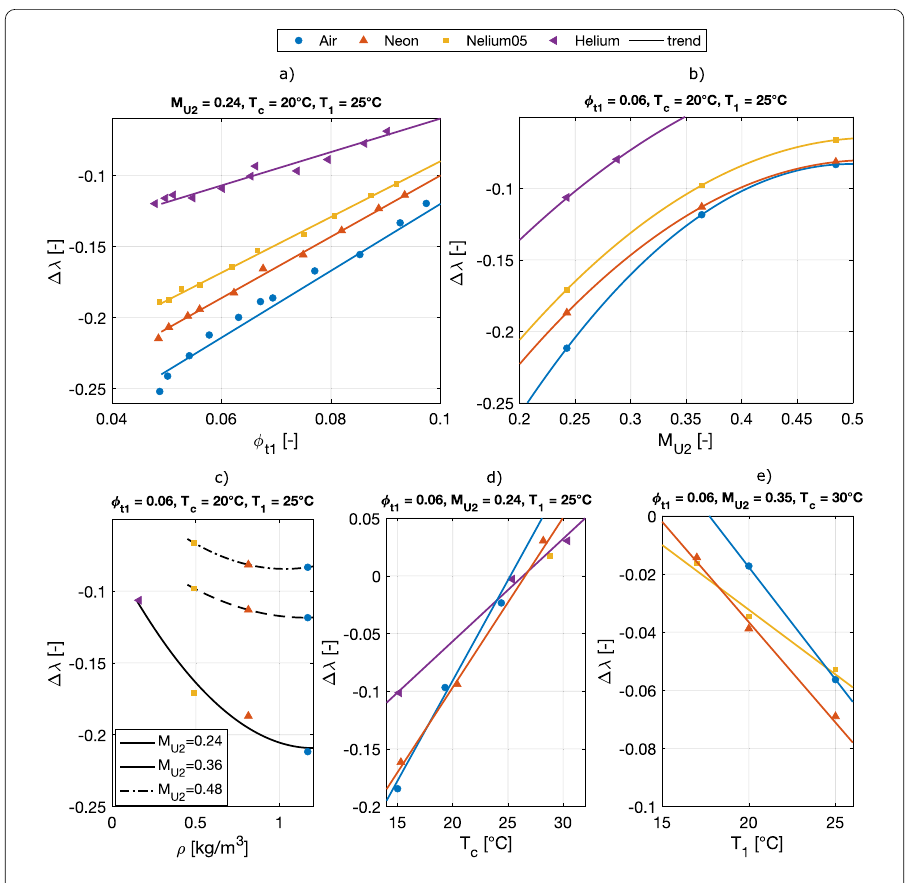
Figure 12 Effect of ( a ) inlet flow coefficient, ( b ) tip Mach number, ( c ) gas properties, ( d ) chiller set temperature and ( e ) inlet stage temperature on the difference between diabatic and adiabatic work